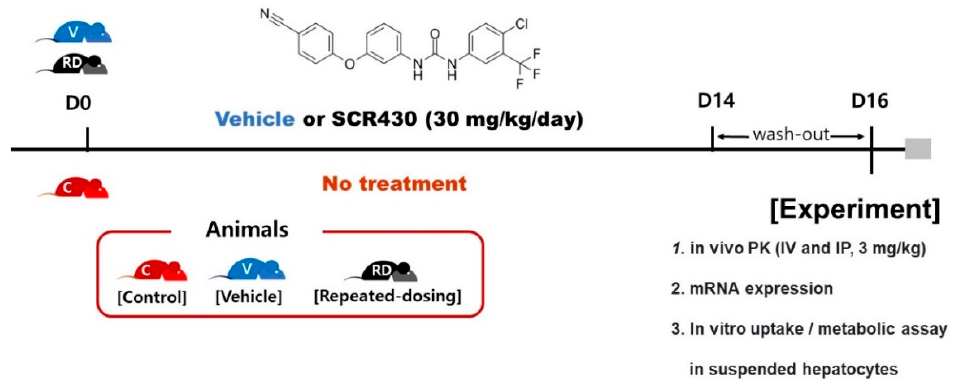
Figure 1. Schematic representation of the experimental procedure’s schedule. In this study, rats were divided into three groups. (1) Control group (red-colored, n = 6): the rats were not given a vehicle or drug; (2) Vehicle group (blue-colored, n = 6): the rats were given a vehicle once a day orally for 2 weeks; (3) Repeated-dosing group (black-colored, n = 6): the rats were given 30 mg/kg of the drug dissolved in the vehicle once a day orally for 2 weeks. After a washout period of two days, the SCR430 that was dissolved in the vehicle was administered intravenously or intraperitoneally at a dose of 3 mg/kg for each group.